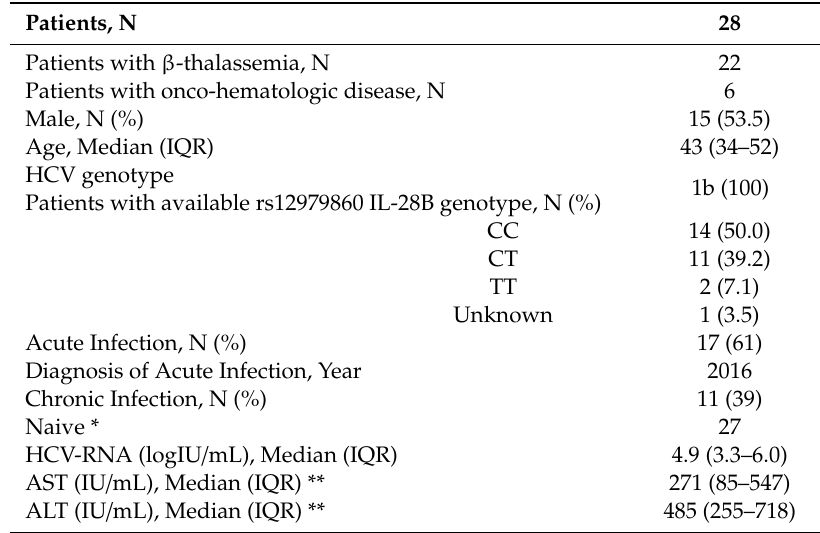
Table 1. Patient